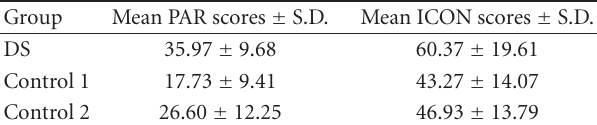
Table 1: PAR and ICON scores.